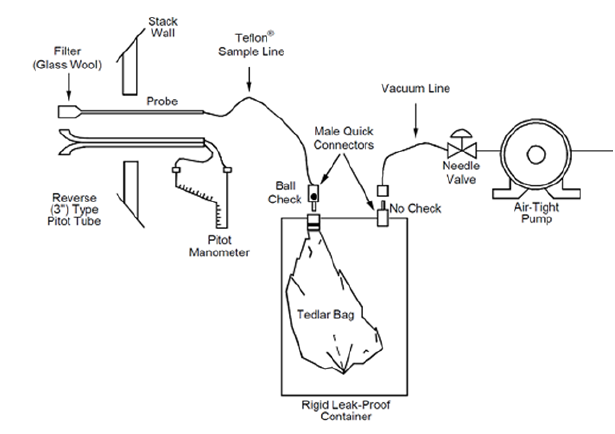
Figure 1. Diagram of the greenhouse gas sampling